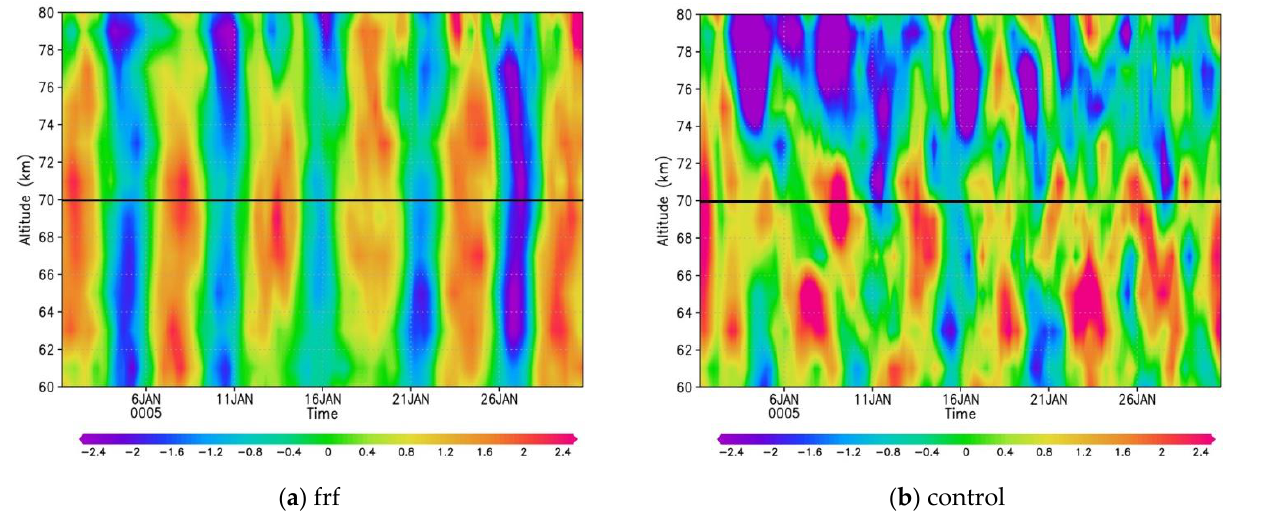
Figure 3. Time-altitude cross-sections of zonal wind (m/s) deviation from its zonal and time averages at 10° W and the equator from 1 January, 5th year for the ( a ) frf and ( b ) control cases. Black lines indicate 70 km altitude.